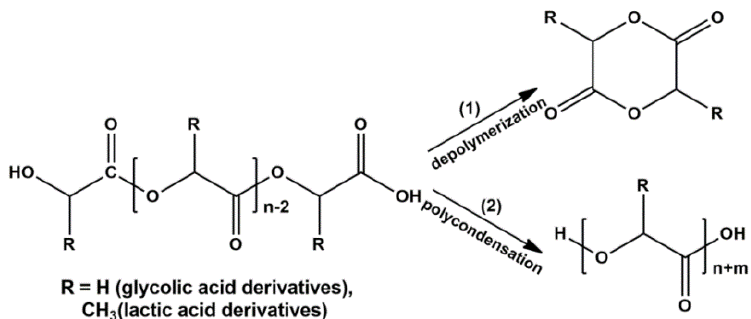
Figure 2. Possible reactions for GAO and LAO: depolymerization (1) and polycondensation (2).